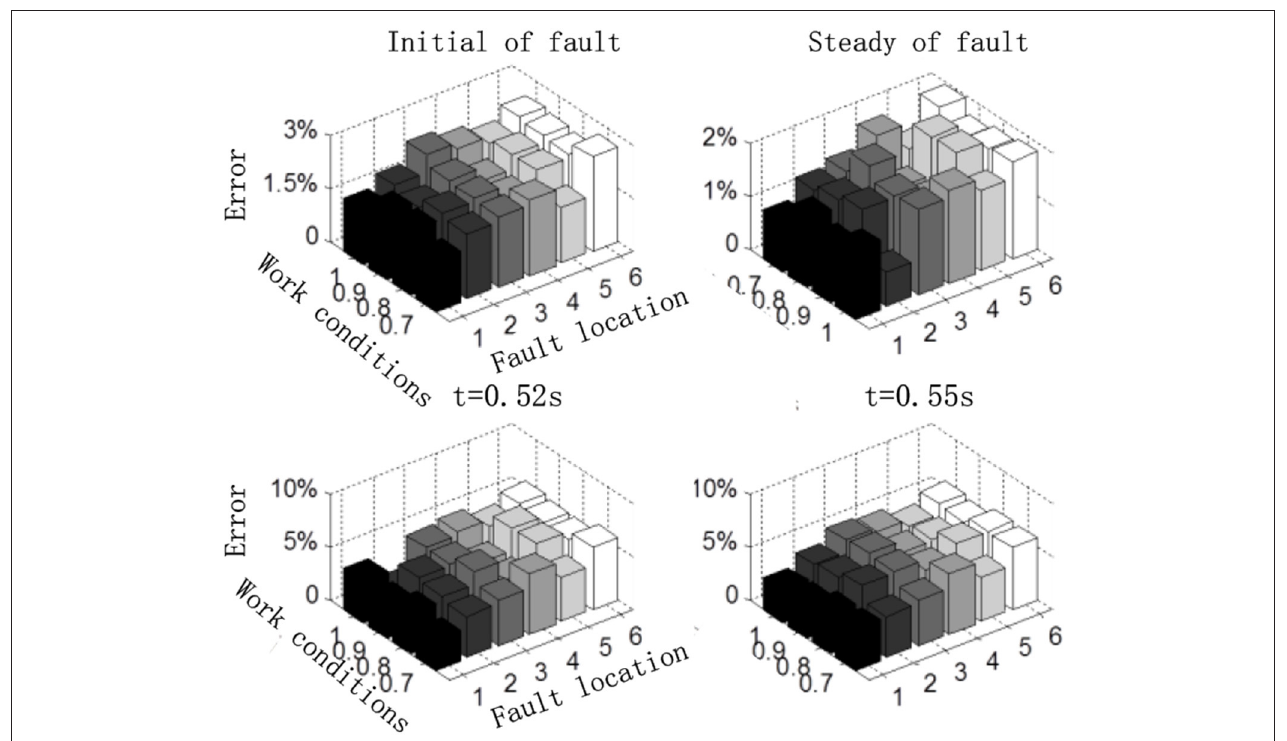
FIGURE 8 | Comparison between the calculation result and experimental result of the short-circuit current.